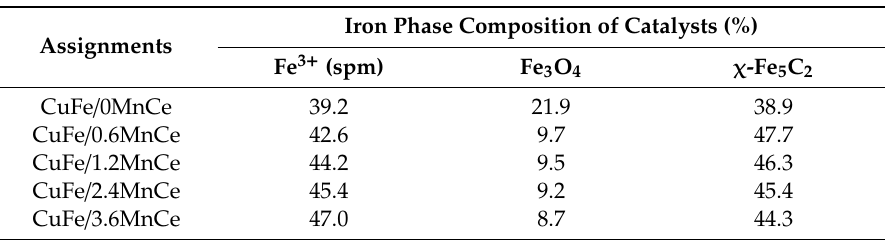
Table 2. MES results of catalysts after